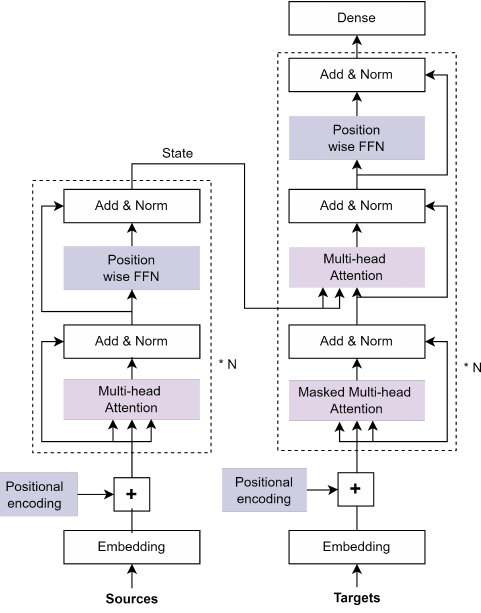
Figure 10. The Transformer